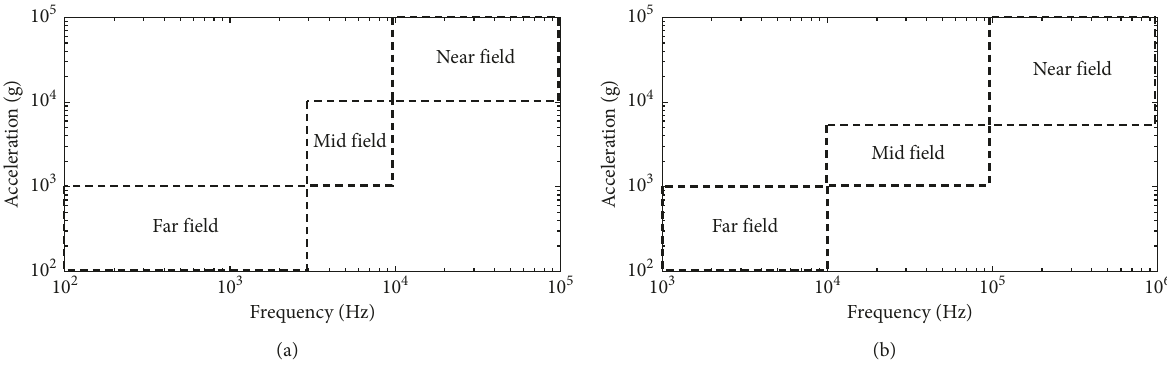
Figure 1: Pyroshock environmental categories: (a) IEST-RP-DTE032 and MIL-STD-810G [5, 6] and (b) NASA-STD-7003